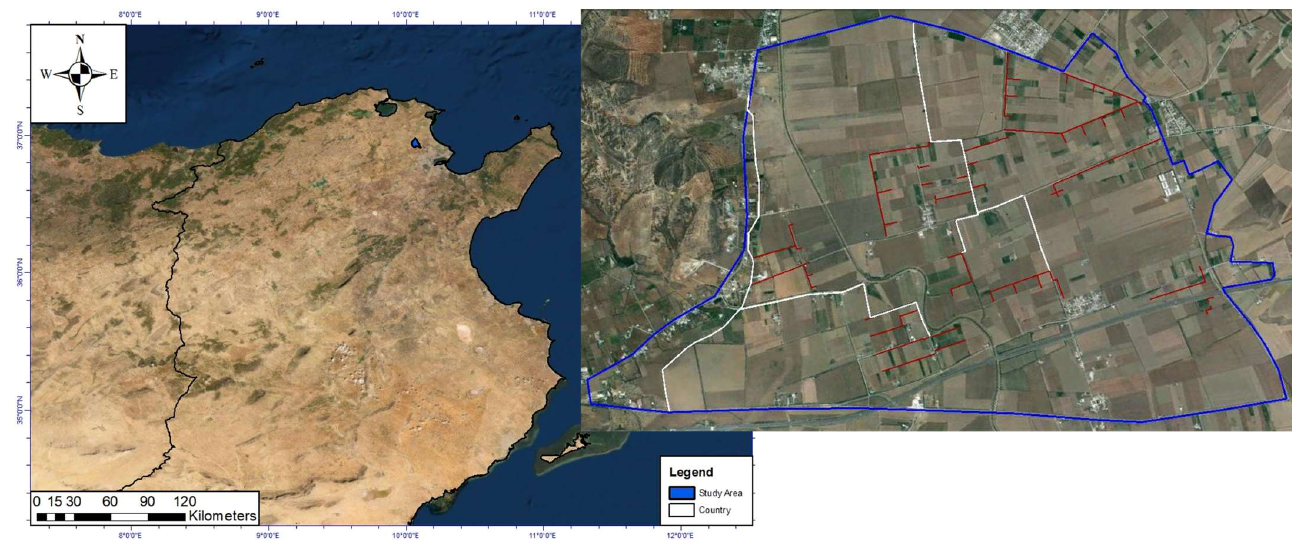
Figure 2. Localization of the Cherfech irrigated district.